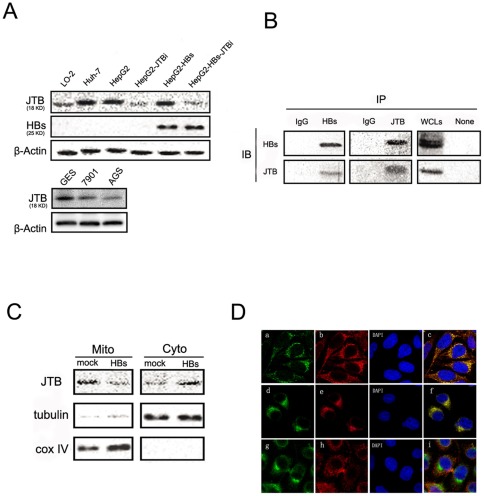
JTB interaction with HBs in HepG2 cells.(A) The expression levels of JTB in HCC cell lines and normal liver cell, JTB in gastric cancer cells and normal gastric cell were determined using western blot analysis. HBs was detected for stable transfected cells. β-actin was used as a loading control. (B) Immunoprecipitation was performed as described in the Materials and Methods section. JTB and HBs were detected by western blot analysis. The whole-cell lysate was used as a positive control. (C) A western blot showing the distribution of JTB in the cytosolic and mitochondrial subfractions. Tubulin and coxIV were used as cytosolic and mitochondrial markers, respectively. (D) The effects of JTB on the mitochondrial localization and co-localization of JTB and HBs. Cellular localization by the immunocytochemical analysis of JTB and HBs in HepG2 cells using (a, b) FITC-labeled anti-JTB (green) and Texas red-labeled anti-coxIV (red) antibodies, (d, e) FITC-labeled anti-JTB (green) and Texas red-labeled anti-HBs (red) antibodies, (g, h) and FITC-labeled anti-JTB FITC (green) and Texas red-labeled anti-coxIV (red) antibodies under confocal microscopy. To label the nuclei, 4′,6-diamidino-2-phenylindole (DAPI) was used (blue). Bars, 10 μm.